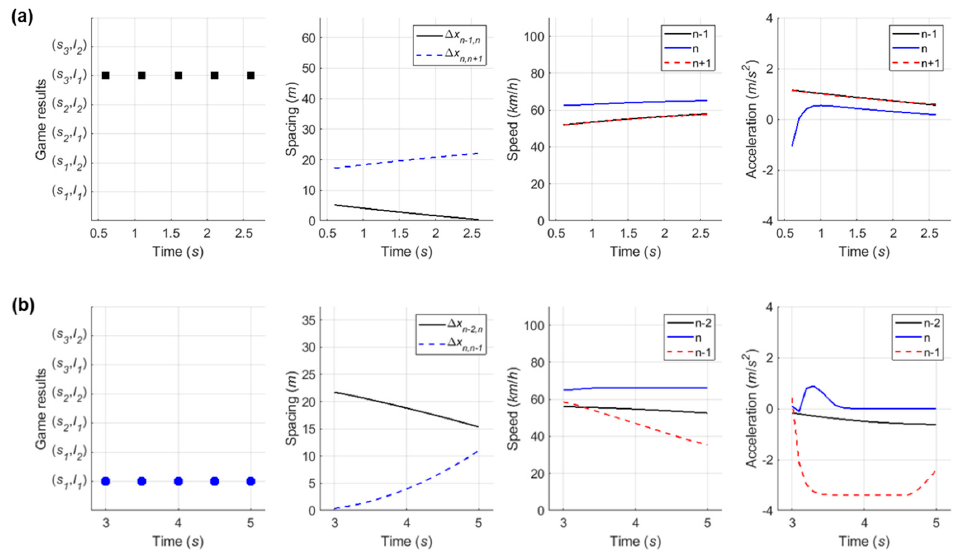
Figure 21. Decision-making game results in case 3: ( a ) Initial game with n + 1; ( b ) additional game with n − 1.